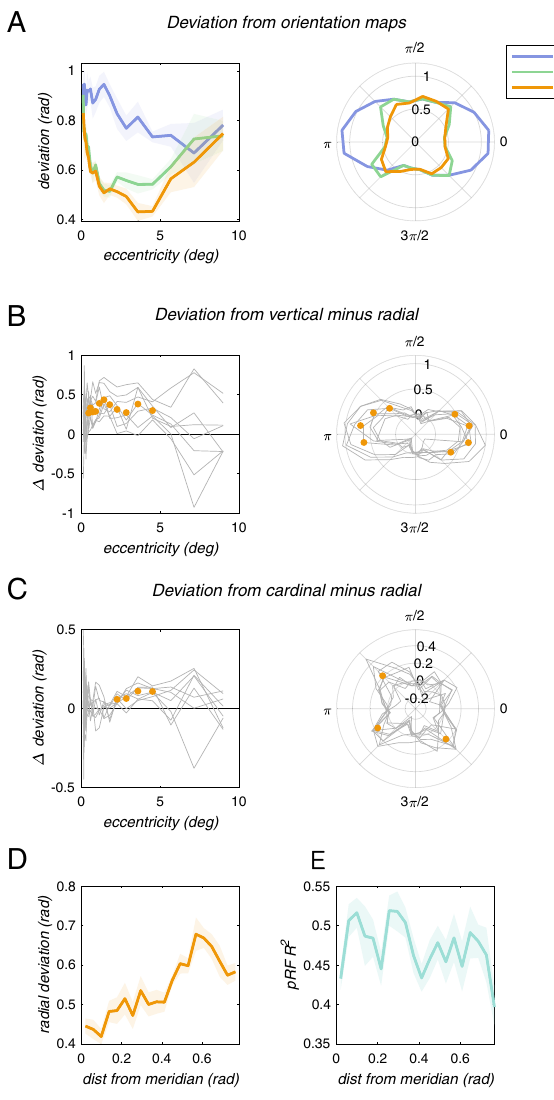
Fig. 5 | Coarse-scale bias is mostly radial in organization. A Deviation of pre- ferred orientation from ideal vertical (blue), cardinal (green), and radial (orange) maps,asafunctionofpRFeccentricity(left)andpRFangle(right). B Deviationfrom verticalminusdeviationfromradial,asafunctionofpRFeccentricity(left)andpRF angle (right). Gray lines, individual subjects. Orange points, signi fi cantly lower deviation from radial than from vertical ( p <0.05, one-way t -test, seven degrees of freedom,nocorrectionformultiplecomparisons). C Deviationfromcardinalminus deviation from radial as a function of pRF eccentricity (left) and pRF angle (right). Gray lines, individual subjects. Orange points, signi fi cantly lower deviation from radial than from cardinal ( p <0.05, one-way t -test, seven degrees of freedom, no correction for multiple comparisons). D Deviation from radial as a function of angular distance from the closest meridian. E pRF R 2 as a function of angular dis- tance from the meridian.